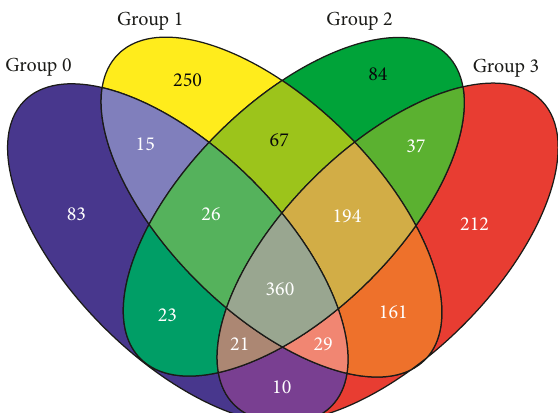
Figure 1: 4-way Venn diagram depicting the distribution of proteins isolated from urinary exosomes of healthy controls (group 0), patients with compensated cirrhosis (group 1), with decompensated cirrhosis (group 2), and with decompensated cirrhosis and kidney injury (group